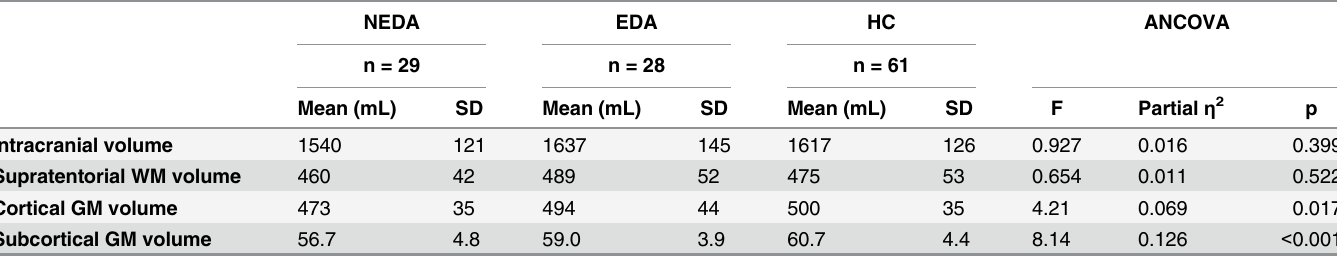
Table 3. Baseline MRI characteristics of patients and